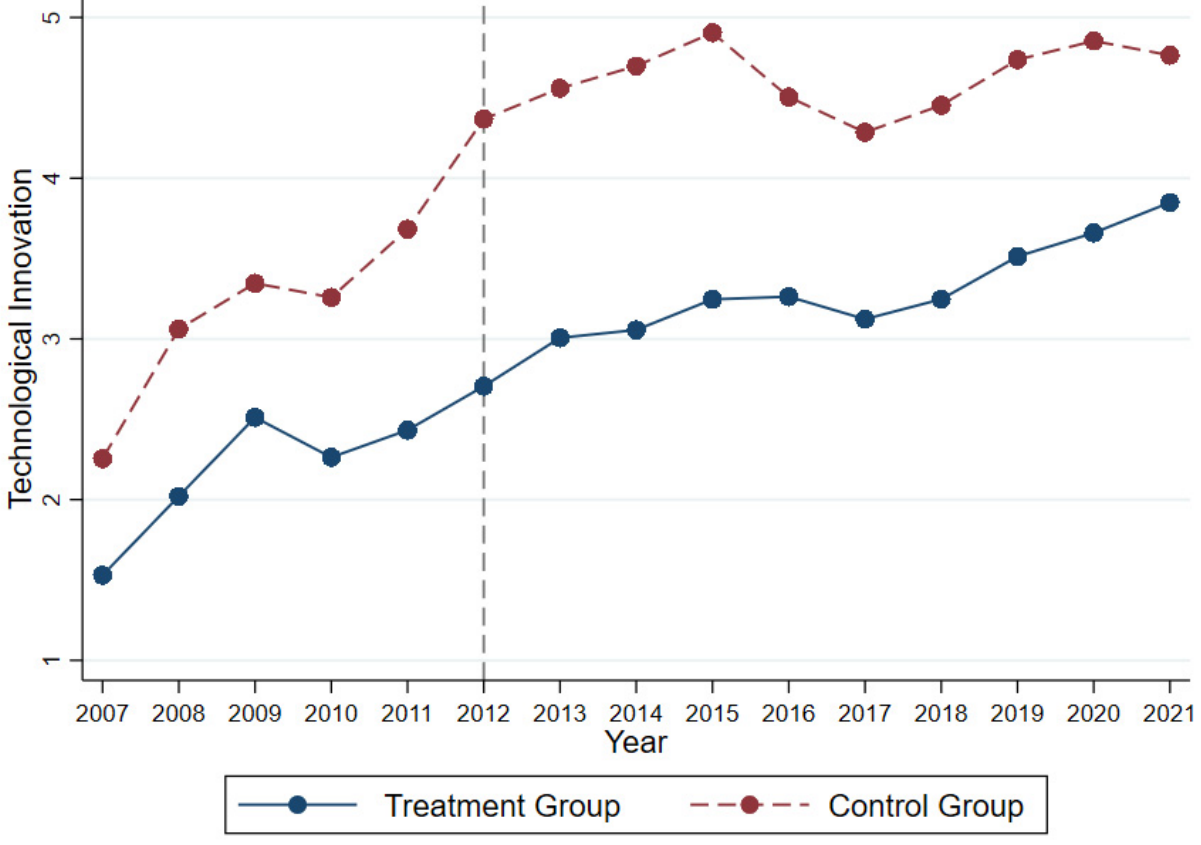
Figure 3. Time trend graph for replacing the dependent variable.